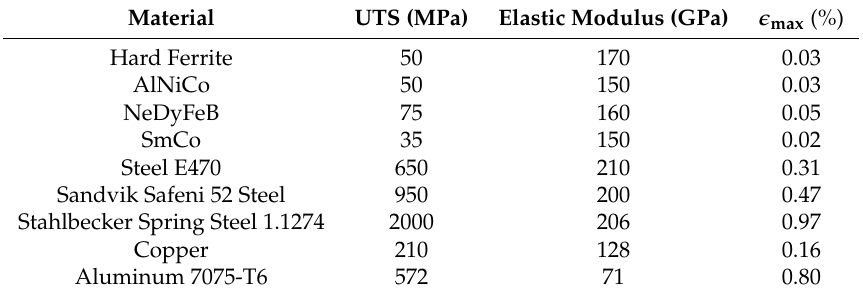
Table 1. Material data on materials [34]. Note that the last column assumes linear elasticity, which is an approximation close to Ultimate Tensile Strength